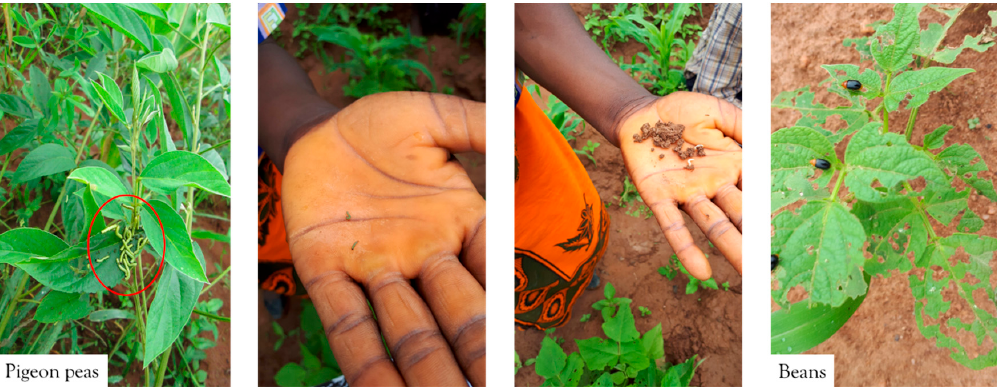
Figure 7. Farmers in the agroecology site showing some insects they named and identified on their farms. Being able to correctly identify such insects is seen by the farmers as the first step to seeking the appropriate